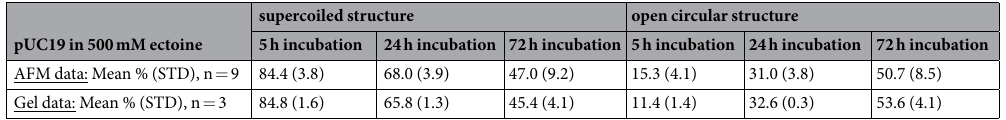
Table 1. Quantitative results from gel electrophoresis and atomic force microscopy outlining the formation of different pUC19 isoforms during incubation with ectoine. * One-way ANOVA, all corrected p-values <